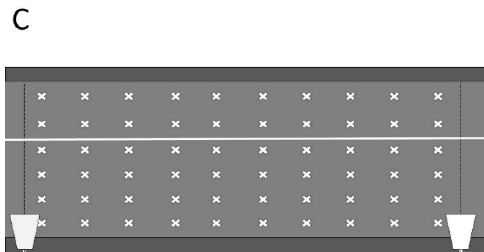
Figure 1. Locations of luminaires (white cones) and points (white x) for average road surface luminance and luminance uniformity measurements. ( A ) Road with two lanes with painted road markings; ( B ) road with two non ‐ separated lanes; and ( C ) pedestrian and bicycle road. Dotted lines show the start and end of the measurement area. Darker areas are outside the road surface. The diagrams are sketches, not scale drawings.